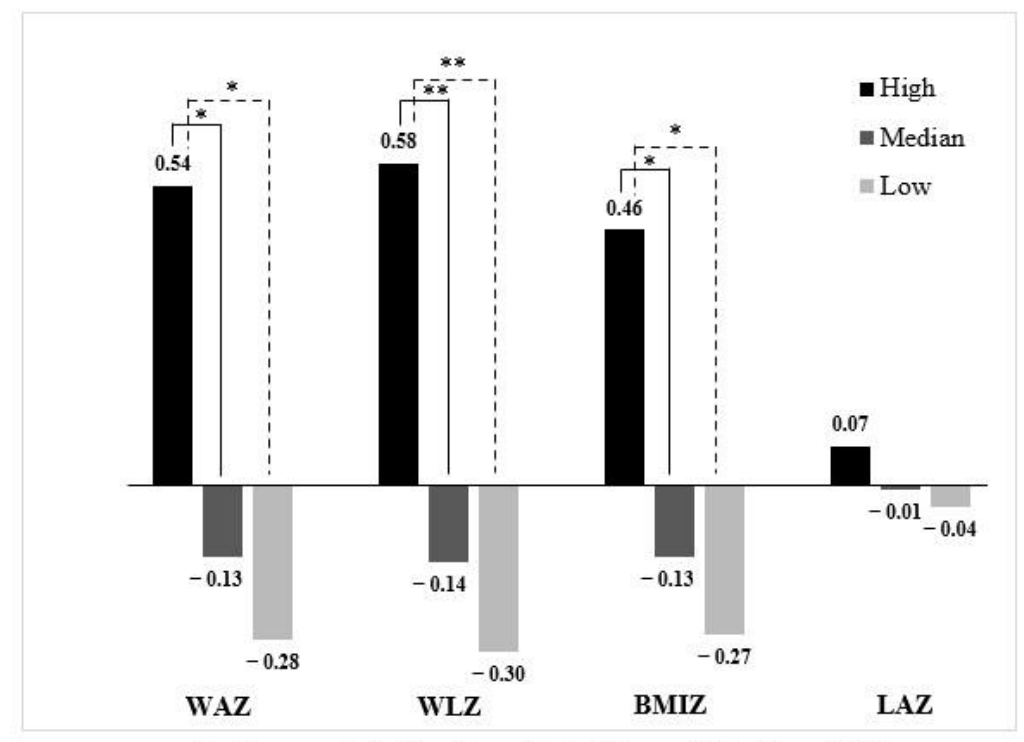
Figure 2. Comparison of conditional growth outcomes among infants consuming different protein Comparison of conditional growth outcomes among infants consuming different intakes. protein